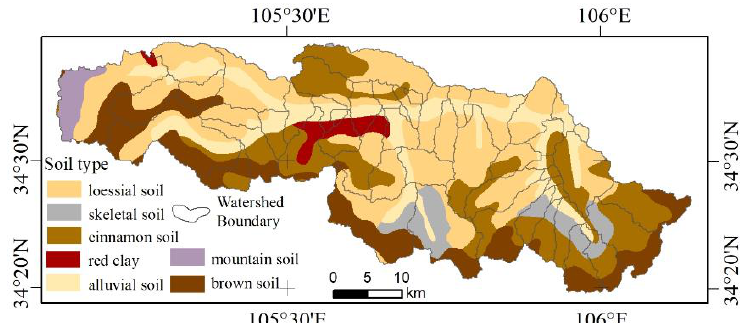
Figure 2. Spatial distribution of soil types in the Xihe River basin.